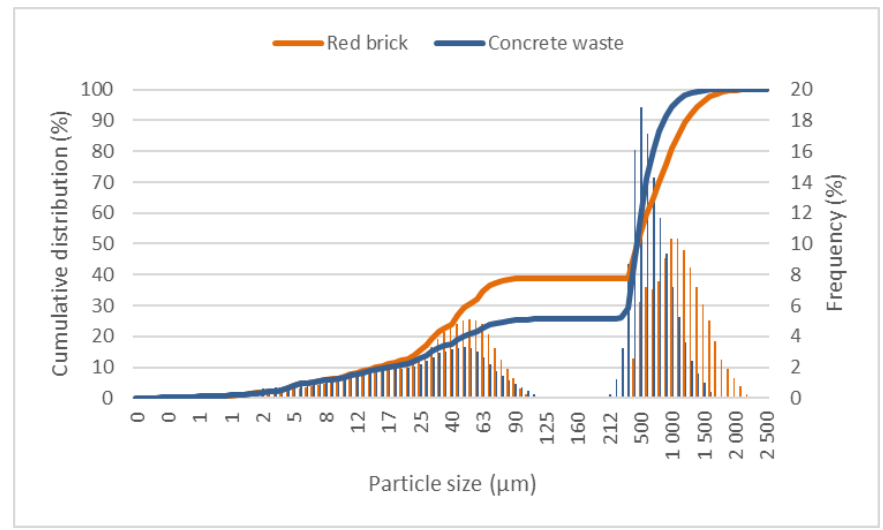
Figure 1. Diagram of particle distribution for clay brick and concrete debris.